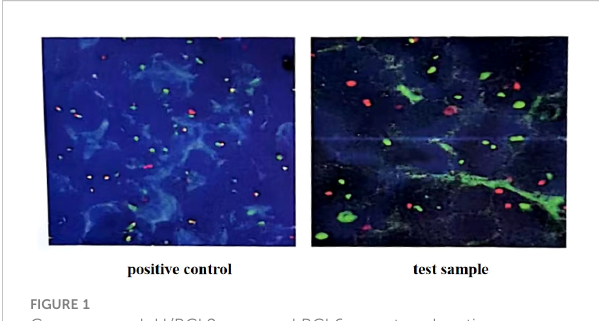
FIGURE 1 C-myc gene, IgH/BCL2 gene and BCL6 gene translocation detection (in the 100 tumor cells counted, more than 15% of the separation signals were interpreted as positive). Fluorescence in situ hybridization con fi rmed the presence of MYC, while BCL2 and BCL6 genes were